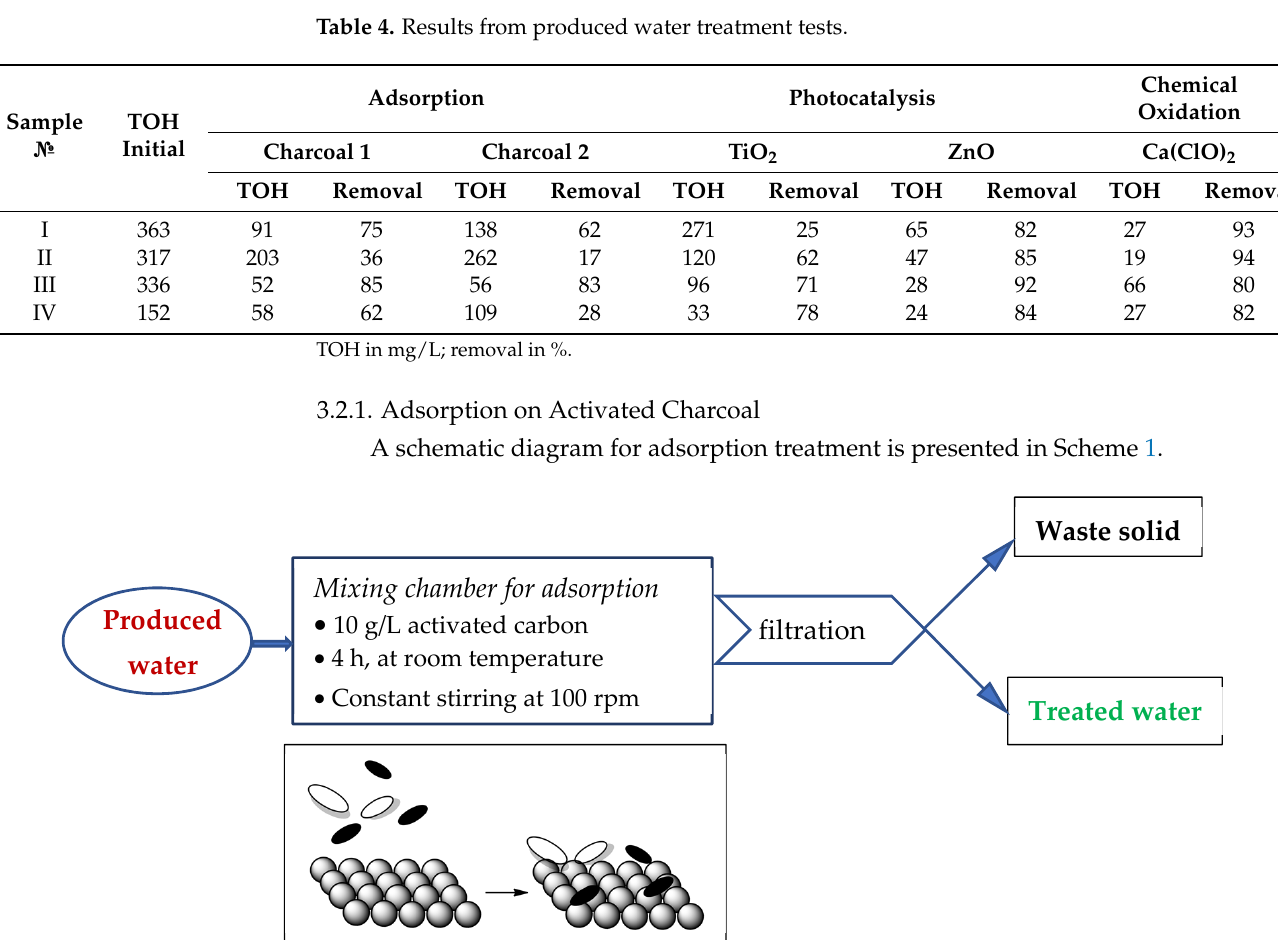
7 Table 3. Specific parameters for the produced water. Sample №